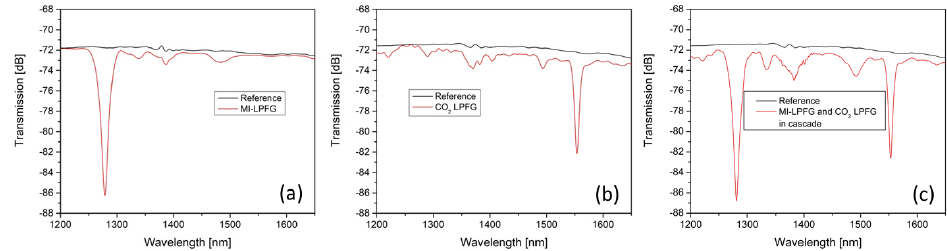
Figure 2. The transmission spectrum of ( a ) mechanically induced long-period fiber grating (MI- LPFG), ( b ) CO 2 LPFG, ( c ) multiplexed MI-LPFG and CO 2 LPFG.